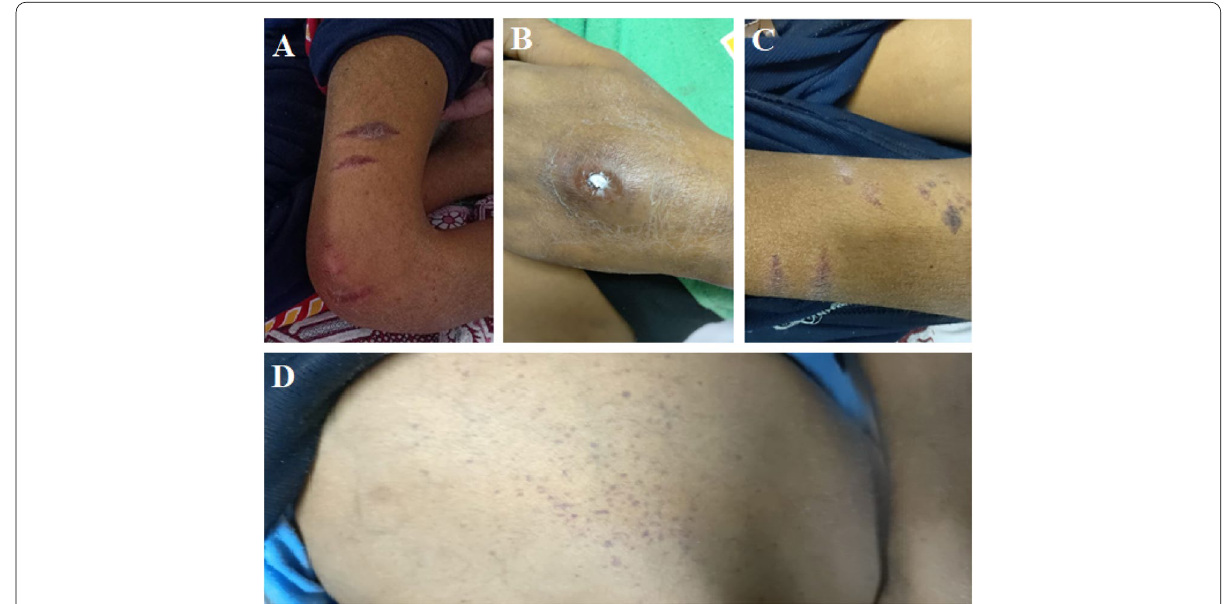
Fig. 3 Skin lesions in the patient with MIS‑C. Multiple skin lesions appeared in the form of petechiae ( D ) and ecchymotic patches ( A & C ) one